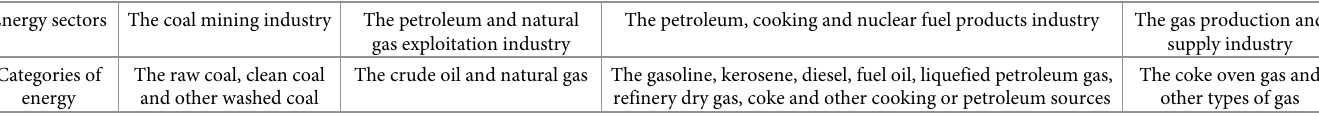
Table 4. The relationship between the various energy sources and the energy